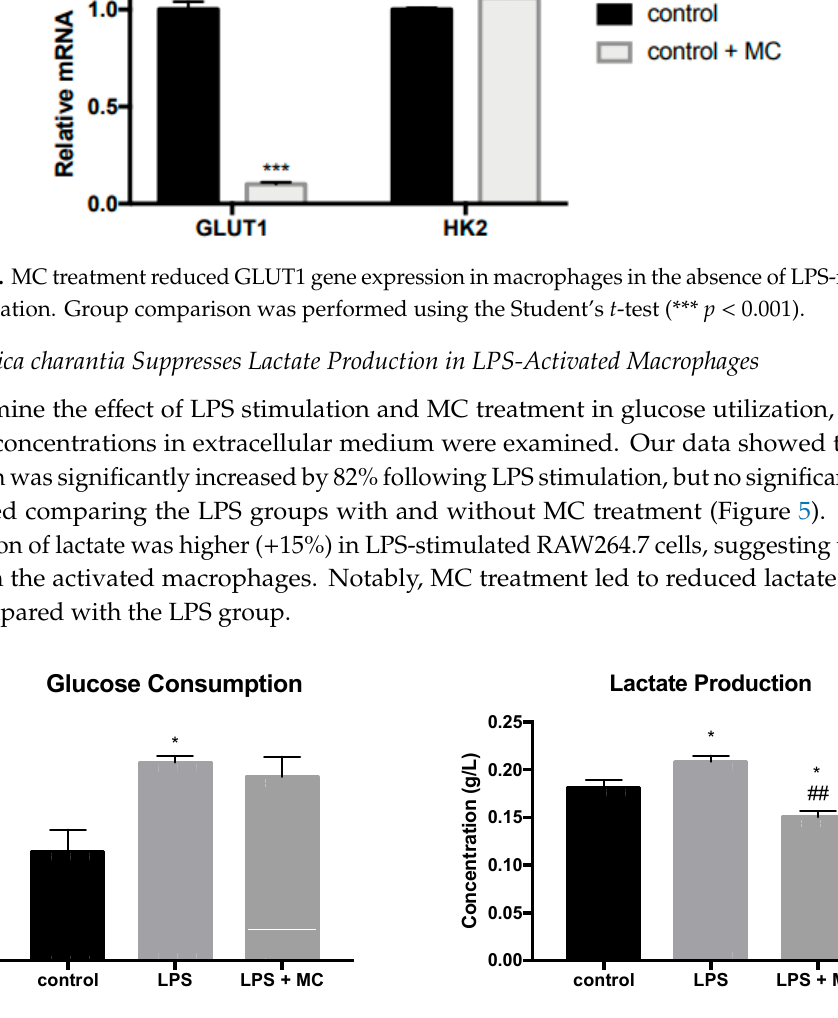
Figure 5. E ff ect of LPS and MC treatments on glucose consumption and lactate production. RAW264.7 macrophages were pre-treated with MC water extract for four hours at the concentration of 12.5% v / v (equivalent to 5 mg / mL soluble MC extract), followed by incubation with 1 µ g / mL LPS for four hours. The control group was treated with an equal volume of MiliQ water for a similar incubation time. Data are expressed as mean ± SEM. Group comparison was performed using the Student’s t -test. * p < 0.05 compared with the control group. ## p < 0.01 compared with the LPS group.